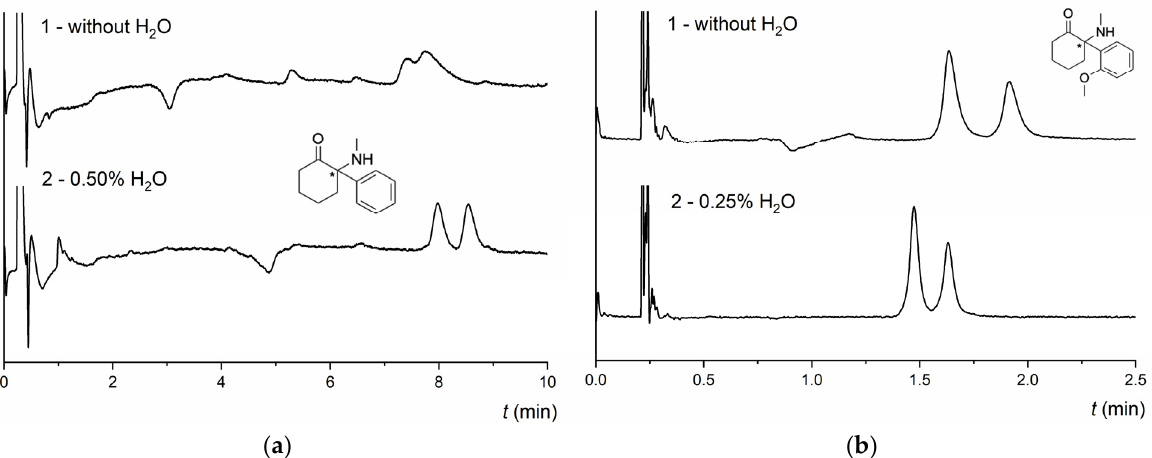
Figure 4. ( a ) Chromatogram of enantioseparation of DXE on the NicoShell column. Chromatographic conditions: MP CO 2 /MeOH/AcA/TEA (90/10/0.1/0.01, v / v / v / v ) (1) and CO 2 /MeOH/H 2 O/AcA/TEA (90/10/0.5/0.1/0.01, v / v / v / v / v ) (2); flow rate 1.00 mL min − 1 ; column temperature 25 °C; BP 13.8 MPa; UV detection 210 nm. ( b ) Chromatogram of enantioseparation of 2-MeO-ketamine on the TeicoShell column. SFC conditions: MP CO 2 /EtOH/PrOH/TFA/TEA (85/12/3/0.2/0.2, v / v / v / v / v ) (1) and CO 2 /EtOH/PrOH/H 2 O/TFA/TEA (85/12/3/0.25/0.2/0.2, v / v / v / v / v / v ) (2); flow rate 1.20 mL min − 1 ; column temperature 25 °C; BP 13.8 MPa; UV detection 280 nm. (*) in the structure indicates a stereogenic center.